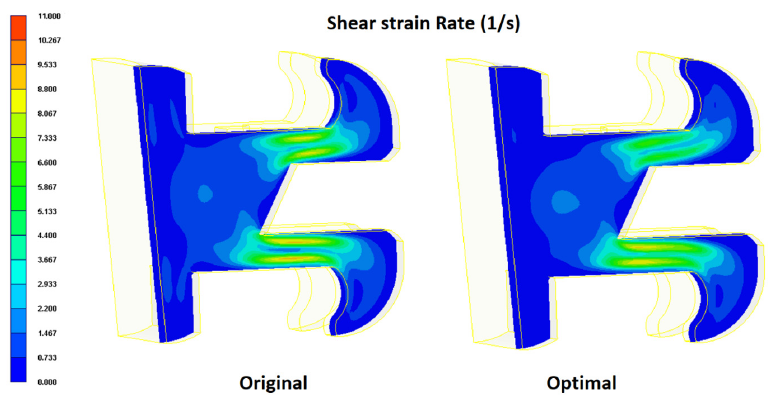
Figure 12. Comparison of shear strain rate distributions in original process design and optimal process design.